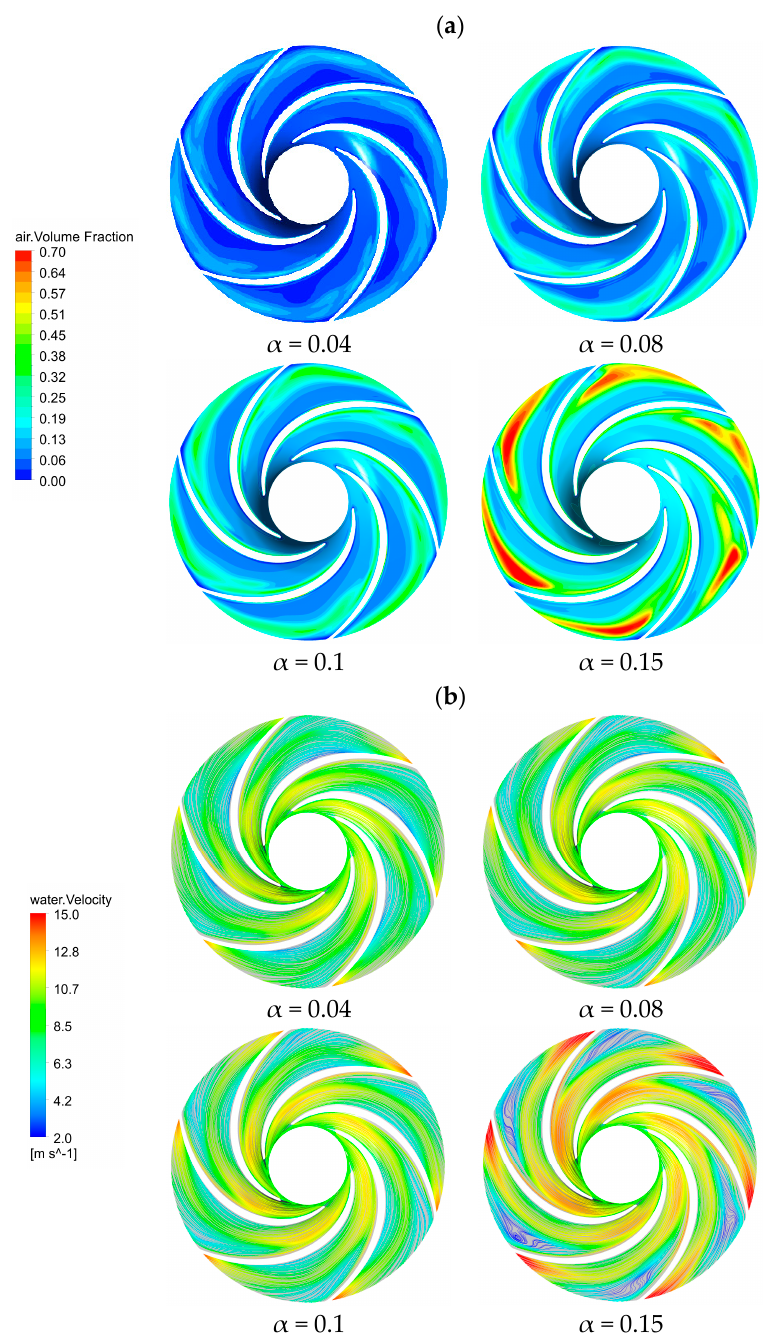
Figure 7. The cross-section of the impeller: ( a ) gas distributions under different inlet gas fractions, ( b ) liquid-phase velocity streamlines distribution under different inlet gas fractions.